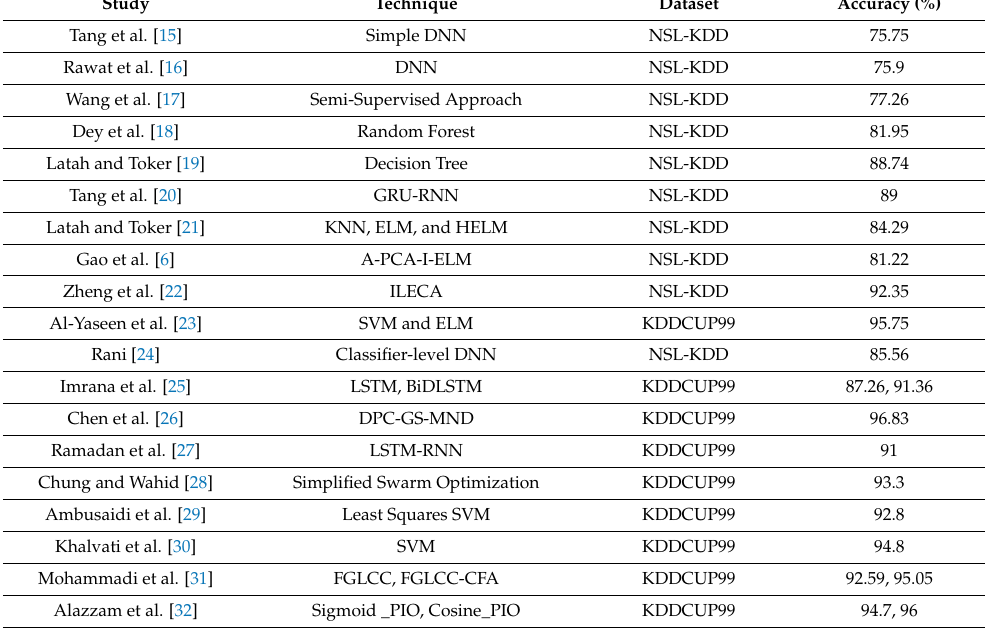
Table 1. Related Work